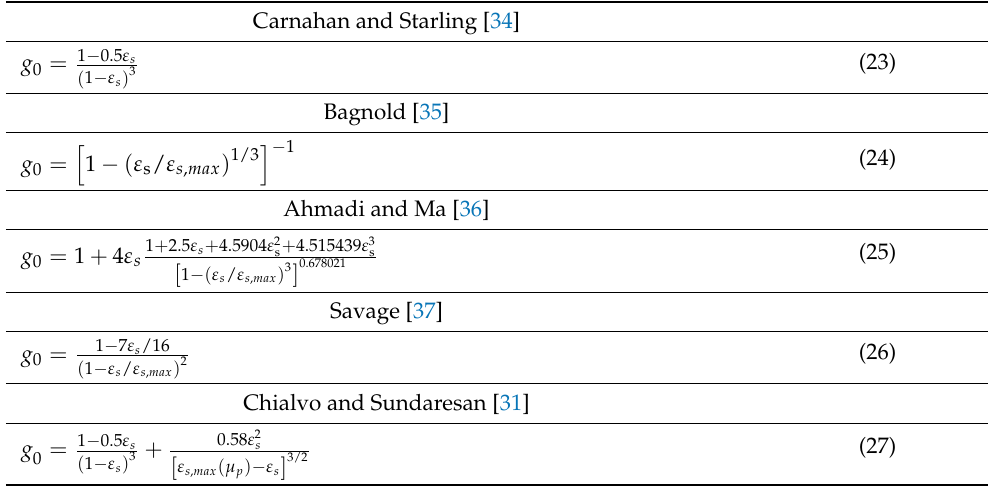
Table 7. Radial distribution